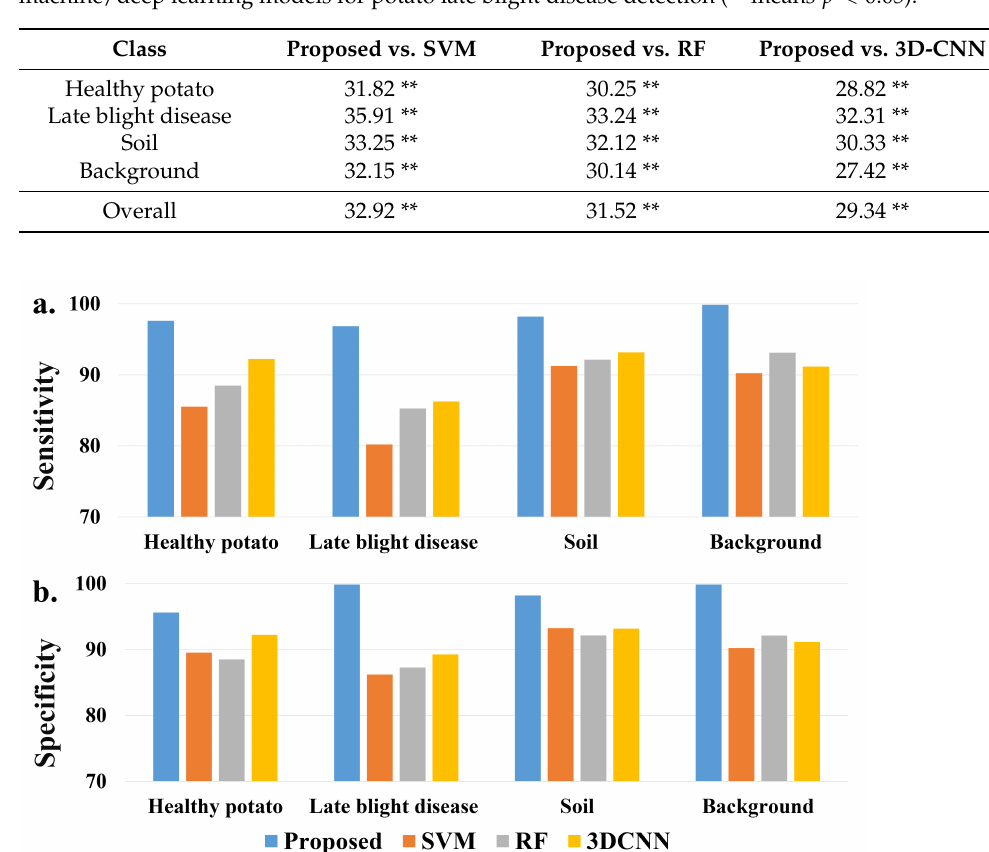
Table 4. The McNemar’s Chi-squared test of the proposed model and the existing representative